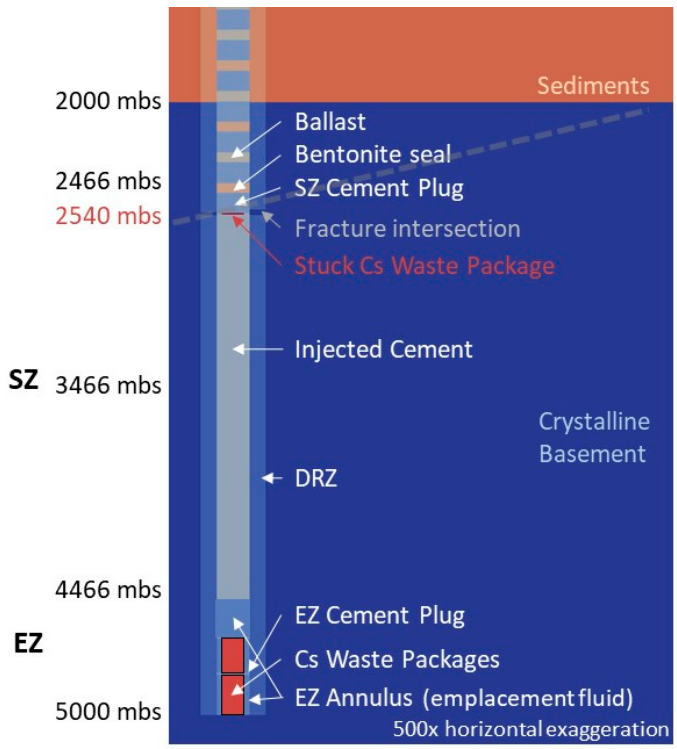
Figure 7. A portion of the DBD PA model domain for the stuck package scenario. Source: Freeze et al. [5].